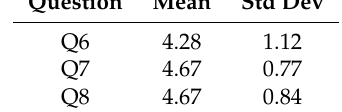
Table 6. The result of usability of questionnaire result of the R-WOSARLS in the experiment group.